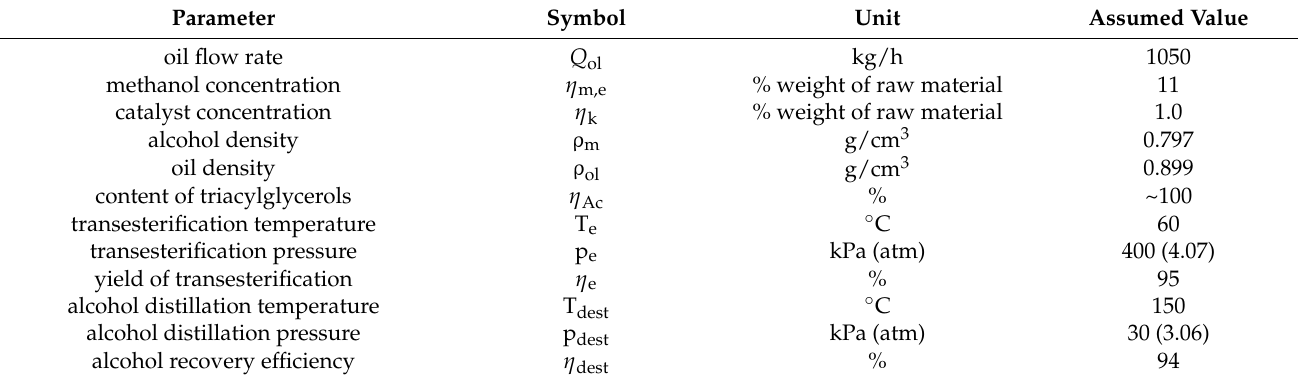
Table 1. Technological assumptions for methanol transesterification and